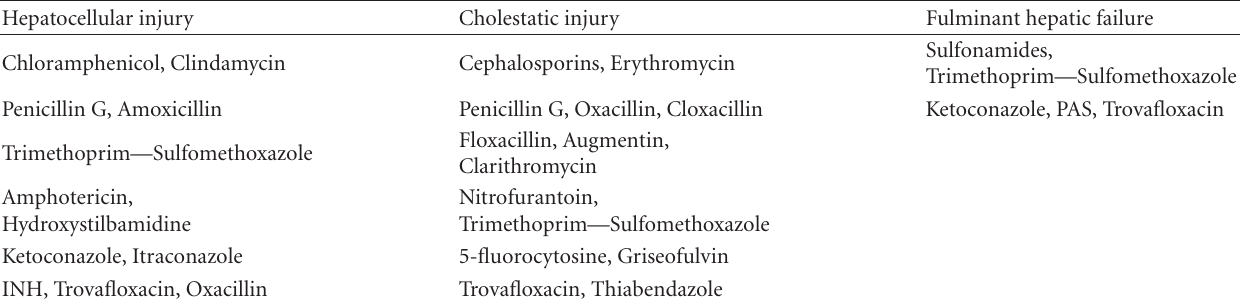
Table 3: Antibiotics causing